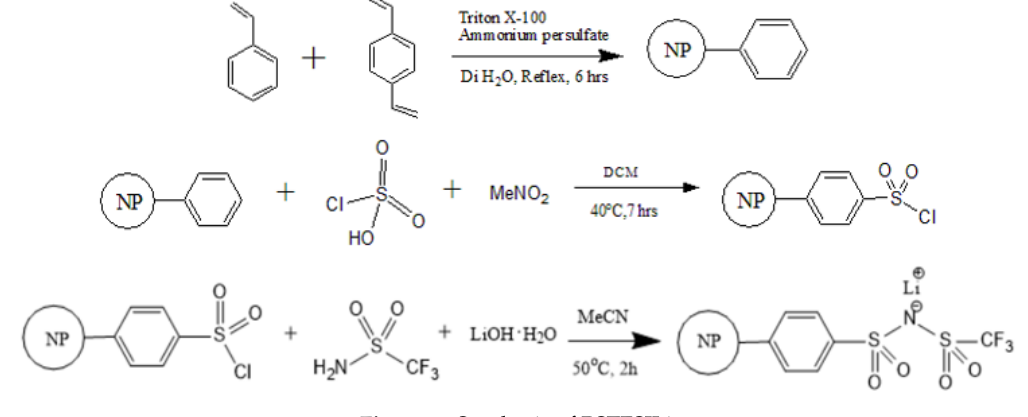
Figure 1. Synthesis of PSTFSILi.